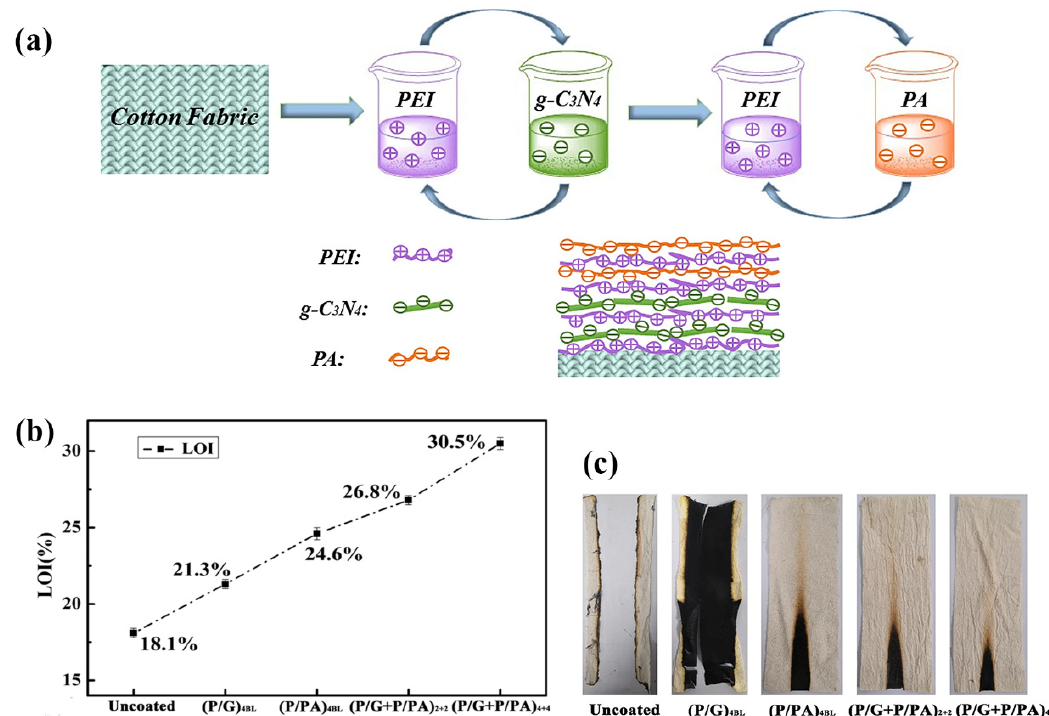
Figure 14. ( a ) Diagrammatic illustration of layer-by-layer (LbL) assembly of cotton fabric. ( b ) LOI values of uncoated and different treated samples. ( c ) Images following the vertical flame test of uncoated and different treated samples. Reprinted with permission from [46]. Copyright 2021, Springer Nature.